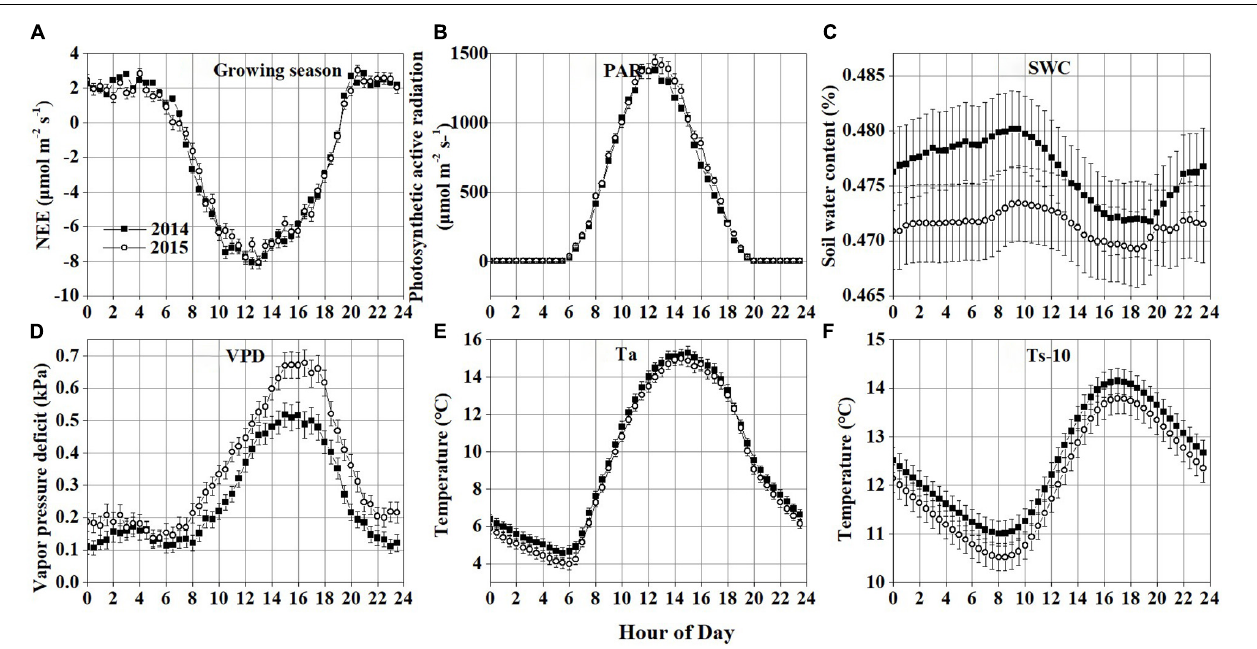
FIGURE 4 | Average diurnal variations during the growing season in 2014 and 2015: (A) net ecosystem CO 2 exchange (NEE) during the growing season; (B) photosynthetically active radiation (PAR); (C) soil water content (SWC); (D) vapor pressure deficit (VPD); (E) air temperature (Ta); (F) soil temperature at 10 cm depth below the ground (Ts-10). Error bars in all plots denote the standard errors. The time axes in the graph record Beijing time (UTC+8).